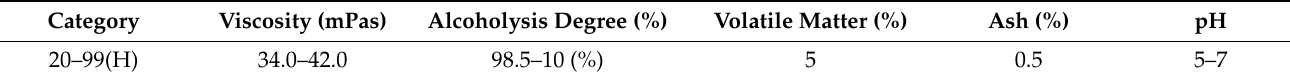
Table 1. Basic properties of polyvinyl alcohol (PVA).